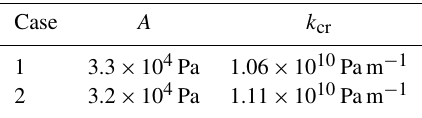
Figure 16. Event cumulative number dependence on the stiffness of the interblock link.